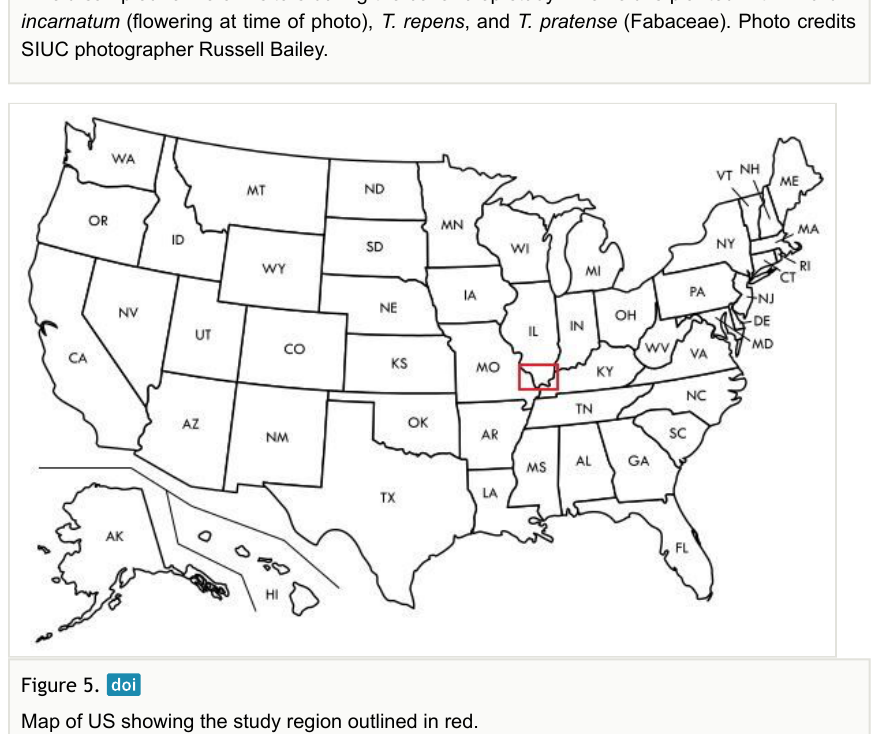
Figure 5. Map of US showing the study region outlined in